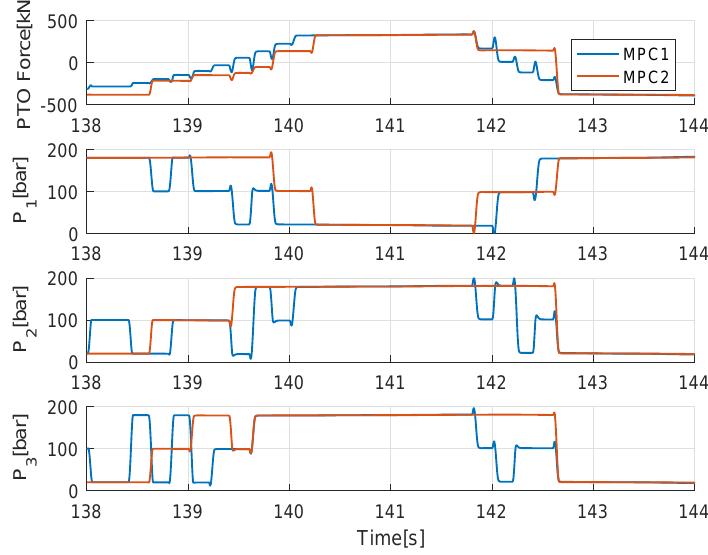
Figure 11. Examples of PTO force and chamber pressures for MPC 1 and MPC 2 using T s = 200 ms.